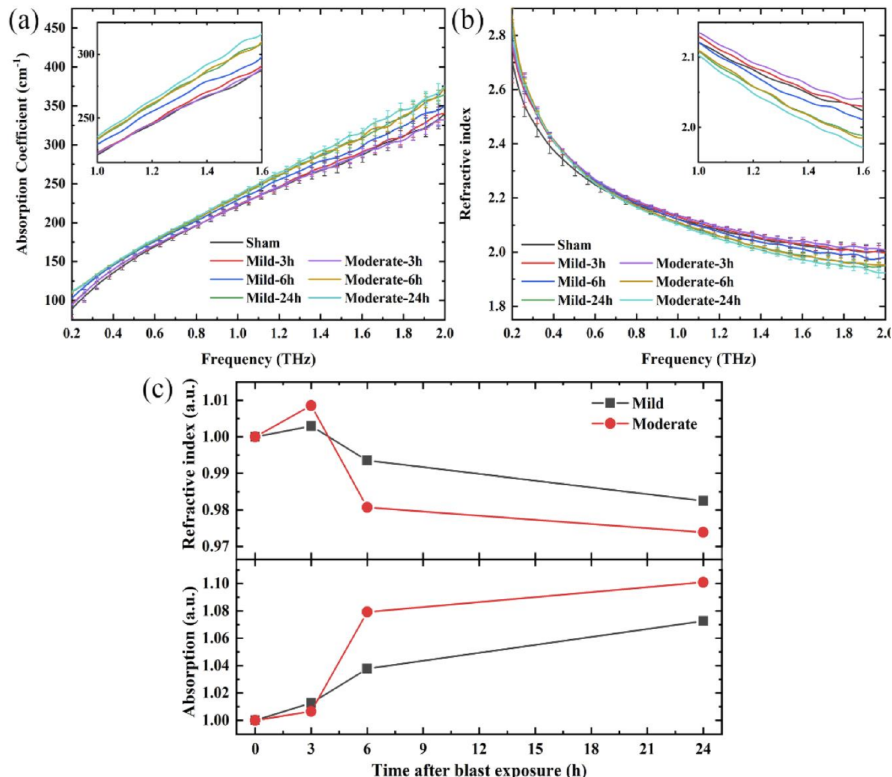
Figure 9. THz spectra of total protein in the hippocampus. ( a ) Absorption coefficient; ( b ) refractive index; ( c ) the normalized absorption coefficient and refractive index values at 1.6 THz. Reprinted from Ref.